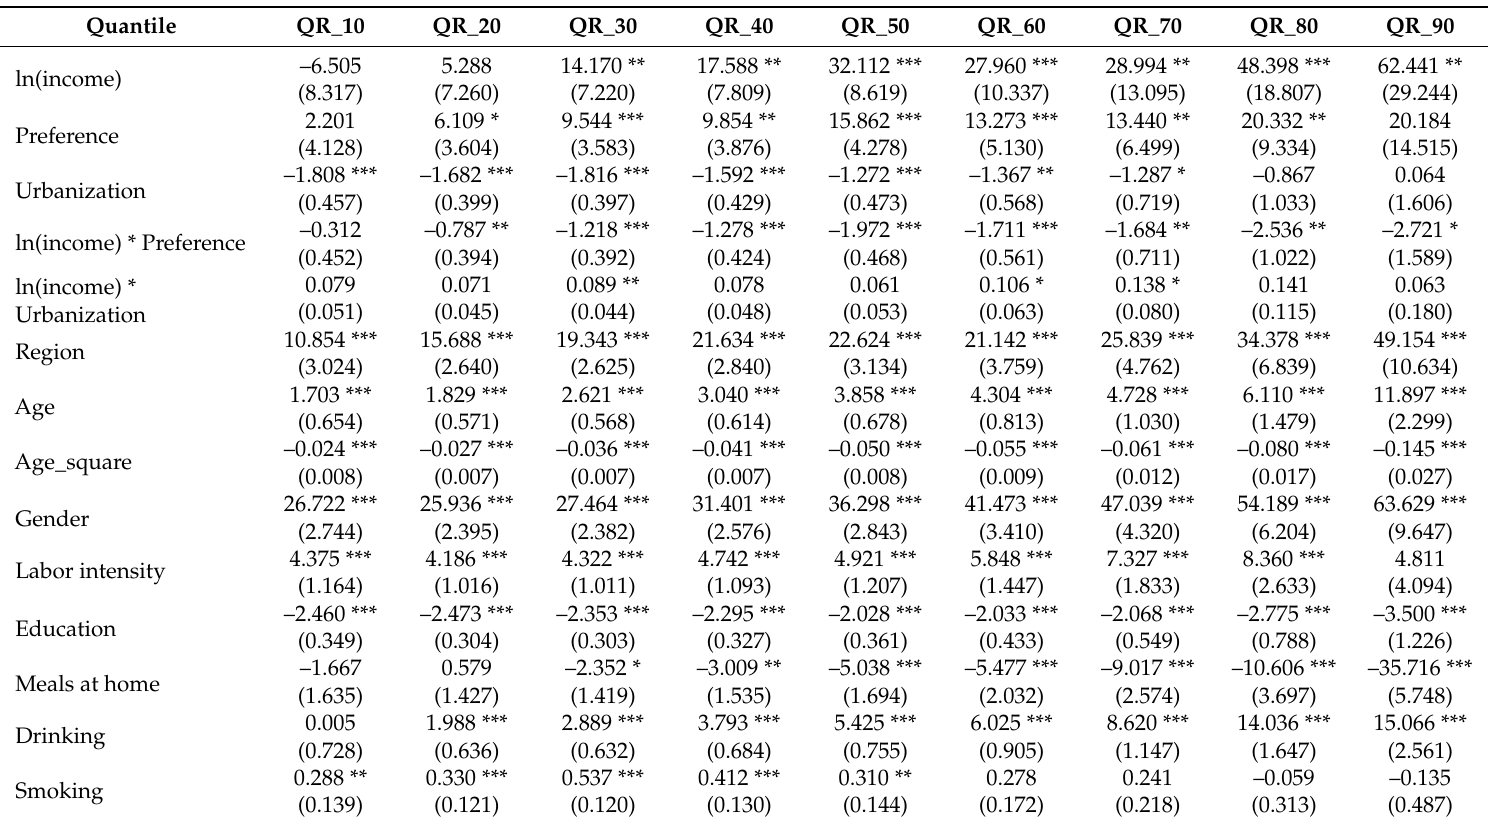
Table 4. Multivariate quantile regressions (n =